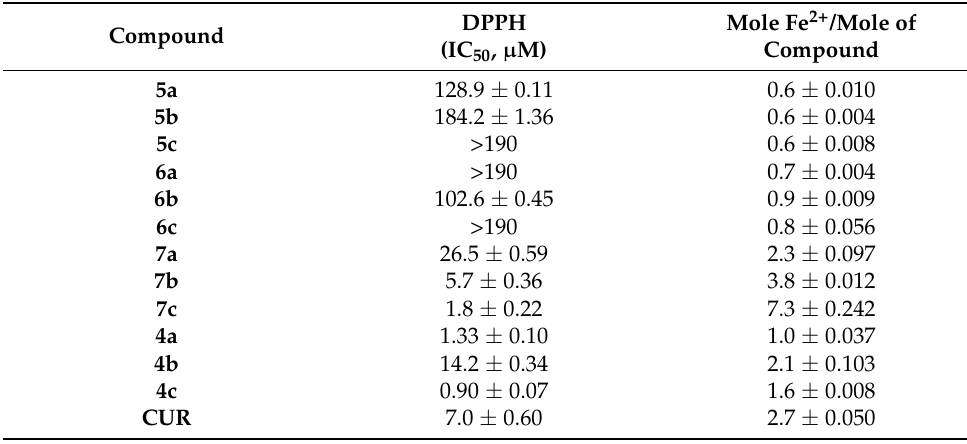
Table 3. Antioxidant properties of the different curcuminoids